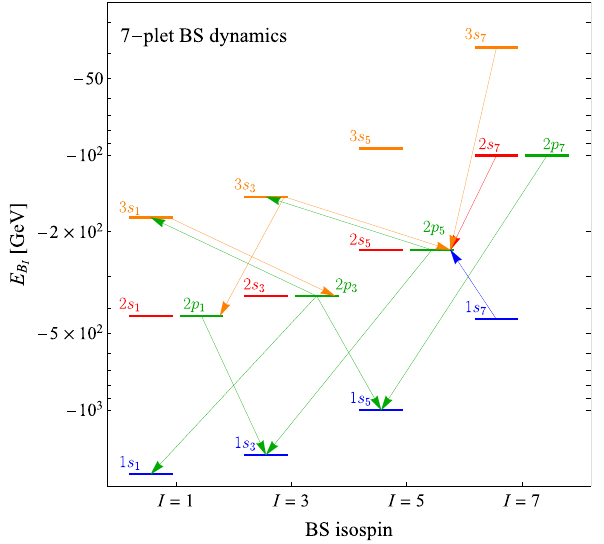
Fig. 11 BS energy levels for the 7-plet: blue n = 1, red n = 2 with L = 0, green n = 2 with L = 1 and orange n = 3. The arrows indicate the decay rate of each state. BS with no lines attached have an annihilation rate at least one order of magnitude larger than the decay